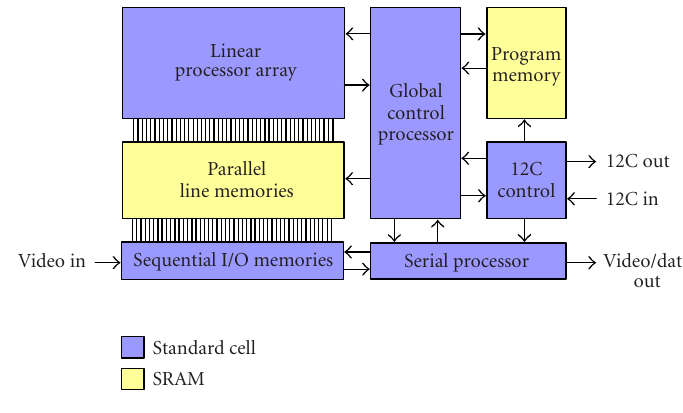
Figure 5: Xetal architecture.